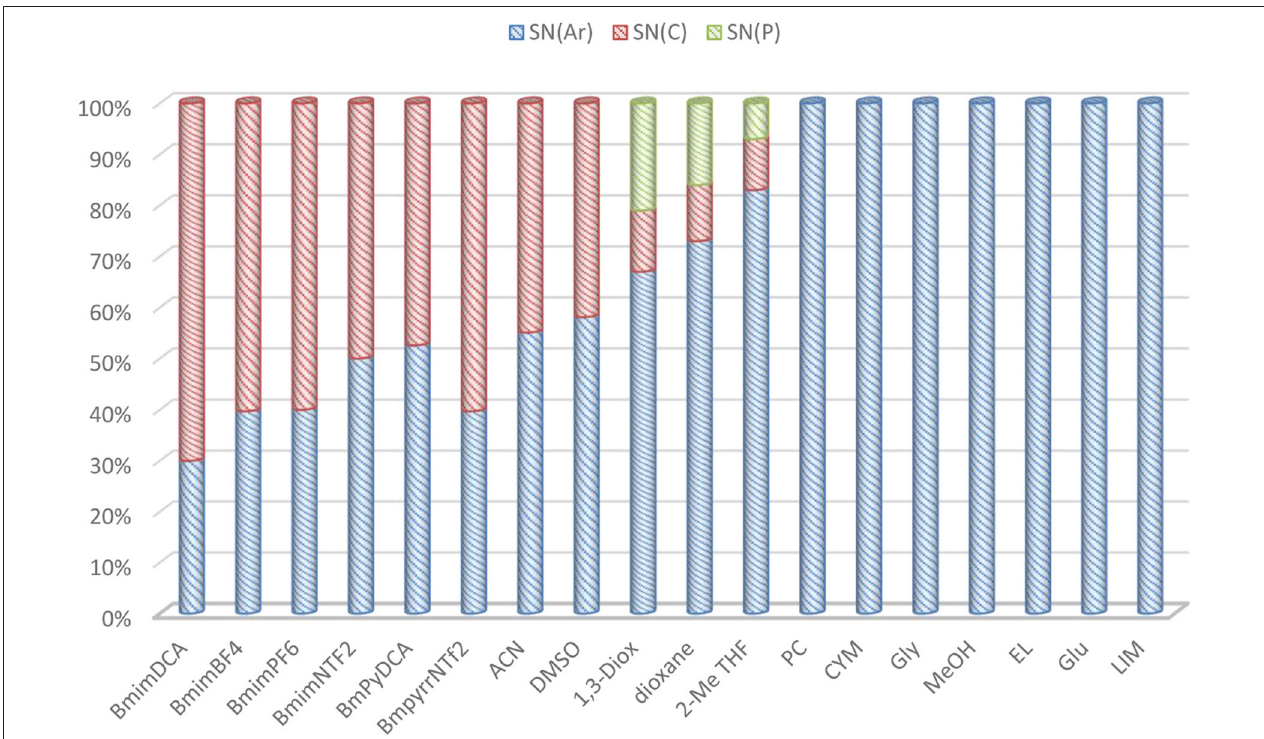
FIGURE 7 | Relative nucleophilic attack of piperidine to 1 in ILs, bio-based and conventional solvents. Attack of piperidine at phosphorus atom of 1c (see scheme 2 ) by S N 2(P) pathway (green columns), C-1 aromatic carbon by S N Ar pathway (blue columns), and aliphatic carbon by S N 2(C) pathway (red columns).